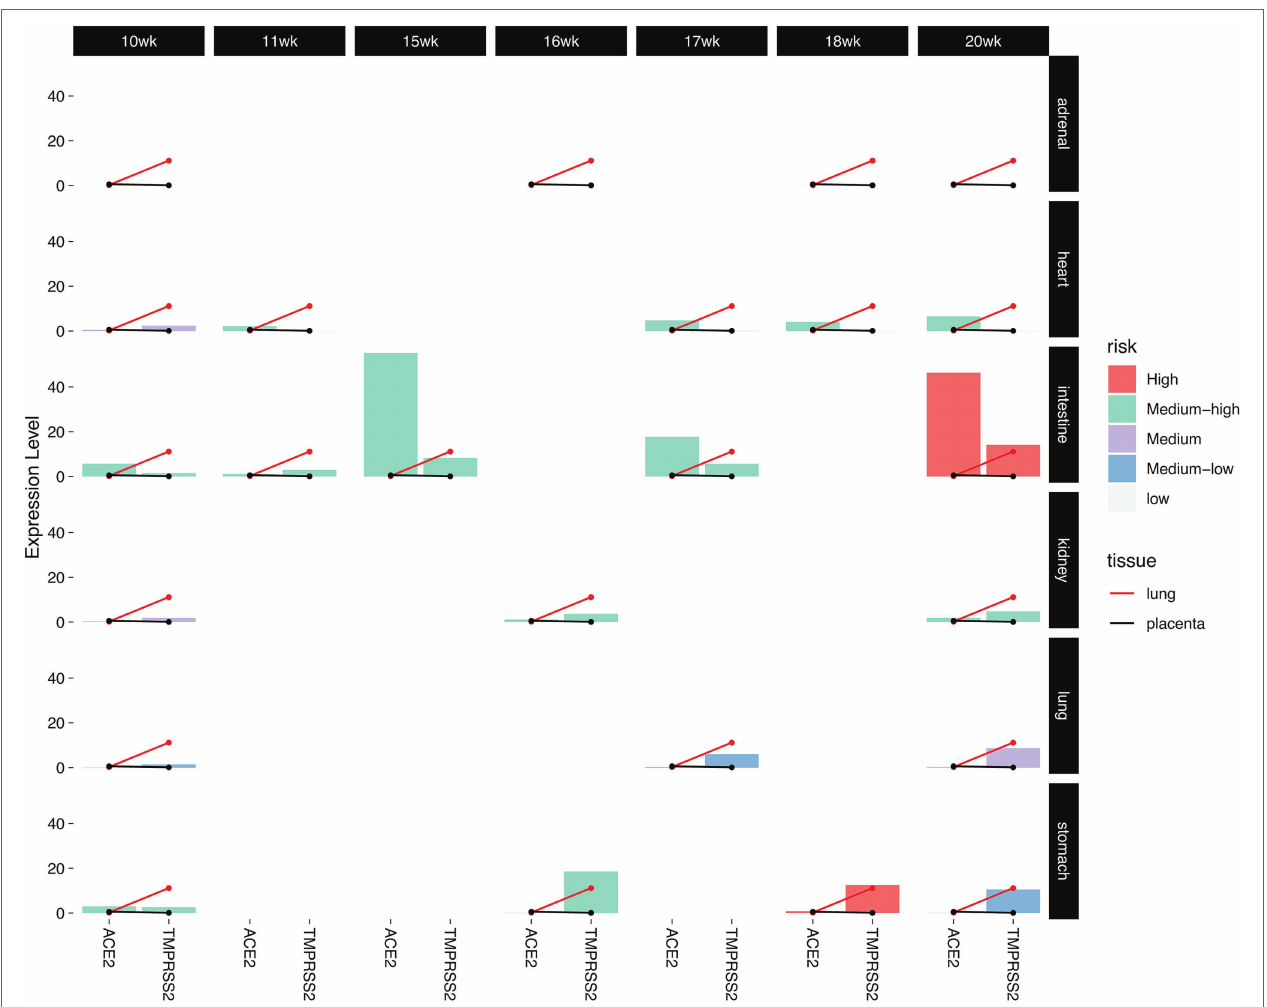
FIGURE 5 | The risk of SARS-CoV-2 infection. The red line is the baseline which represents the expression levels of two SARS-CoV-2 infection-associated factors in adult lung tissue, the black line is the baseline which represents the expression levels of two SARS-CoV-2 infection-associated factors in placenta tissue. The bars reflect the expression levels of two factors in six fetal tissues during fetal development. The colors represent the different